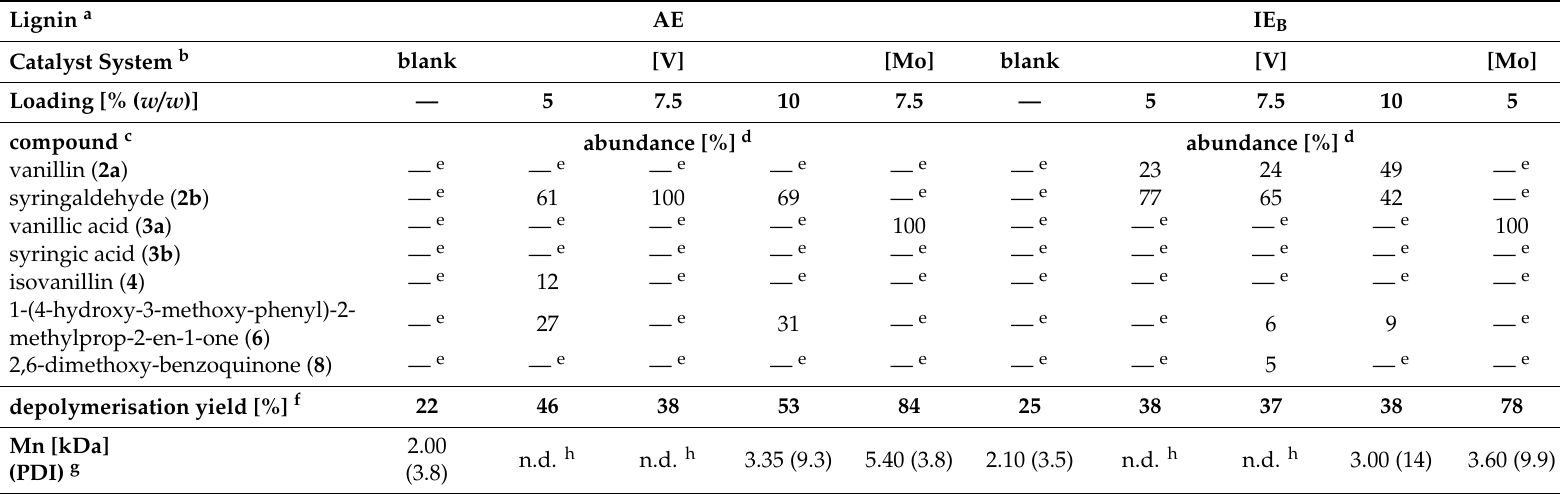
Table 3. Results obtained in the oxidative degradation of aceto- and ionosolv eucalyptus lignins, AE and IE B , respectively, using various loadings of vanadate and molybdate catalyst systems. Lignin a AE IE B Catalyst System